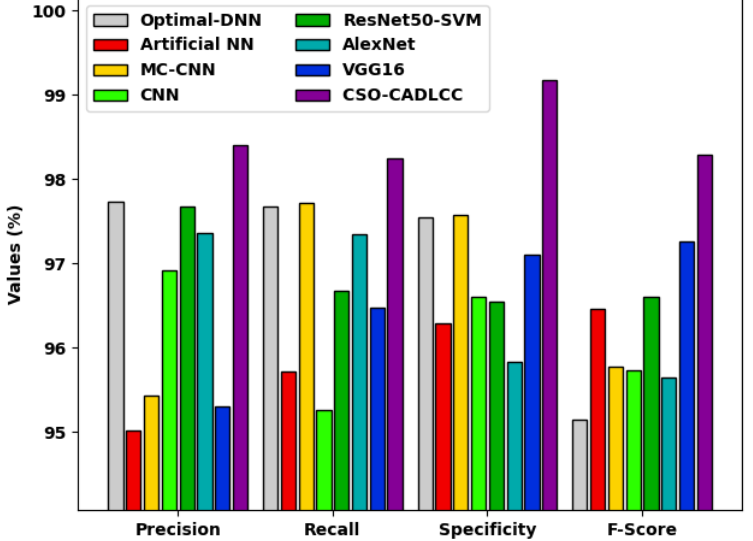
Figure 9. Comparative analysis of the CSO-CADLCC technique with recent algorithms.